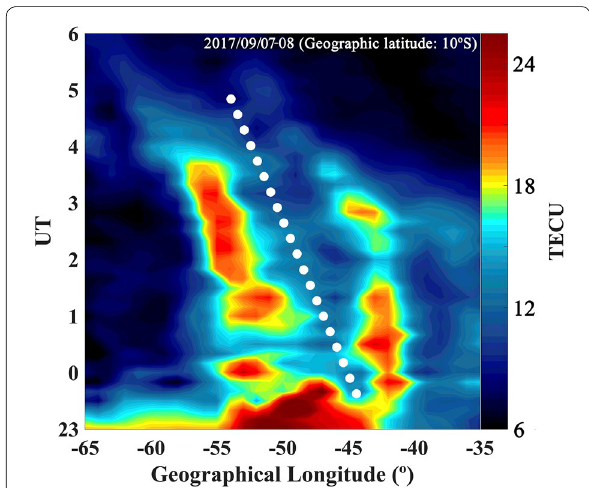
Fig. 5 Keogram related to the TEC data for the geographic latitude of 10°S in the night 07/08. 1 TECU